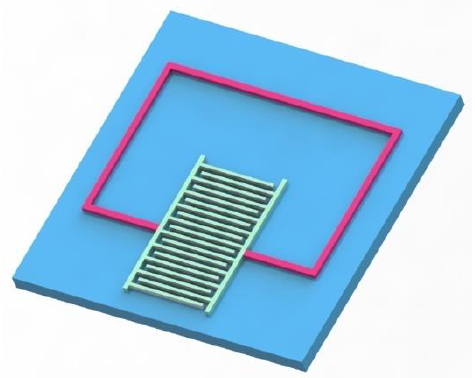
Figure 2. Schematic of sensor: The sensor designed in this article is based on a single-layer structure on a ceramic alumina substrate, with this special structure showing that the inductor and the interdigitated electrode can be printed together on the same surface.